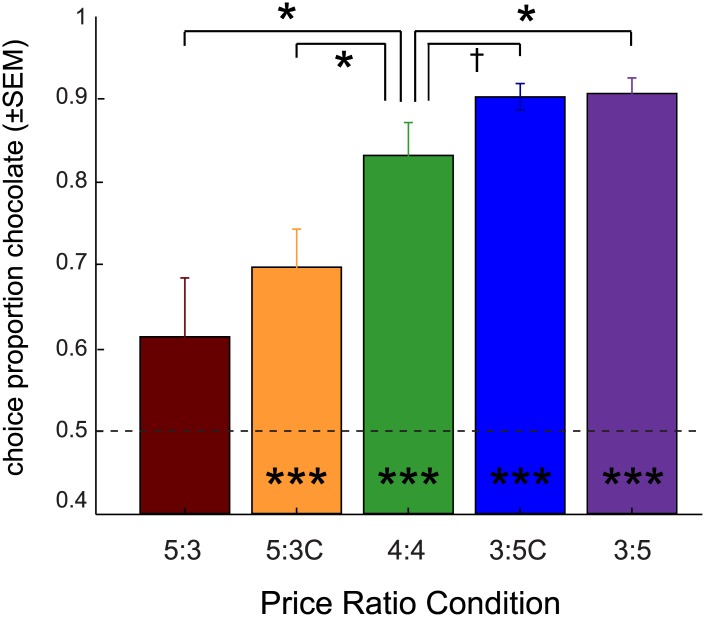
Choice proportion for chocolate per experimental condition Group average preference for the chocolate solution expressed as the proportion of the budget spent (±SEM) on obtaining chocolate, per rat averaged over sessions (N = 8 sessions per condition).In green, the three baseline conditions (4:4 price ratio) were averaged into a single measure per rat. *: significantly different from baseline; p<0.05 paired-sample t-test. †: significantly larger than baseline; p<0.05 paired-sample t-test, one-sided. Dashed line: indifference point, equalling a choice proportion of 0.5. ***: significantly different from chance, p<0.001 one-sample t-test vs. 0.5.